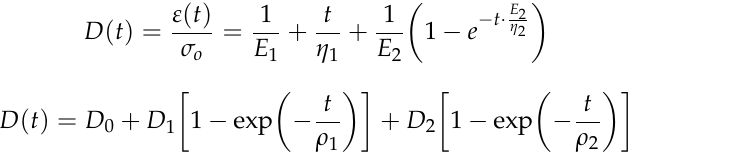
As shown in Equations (4) and (5), both the Burgers model and the second-order Prony series expression can represent the creep compliance D ( t ) of asphalt binder according to the BBR test. The Burgers model takes characteristics of the Maxwell and Kelvin models into account, while the second-order Prony series expression was constructed based on the generalized Kelvin model. As shown in Figure 6, both the Burgers and Prony models can well fit the creep compliance curve in the BBR